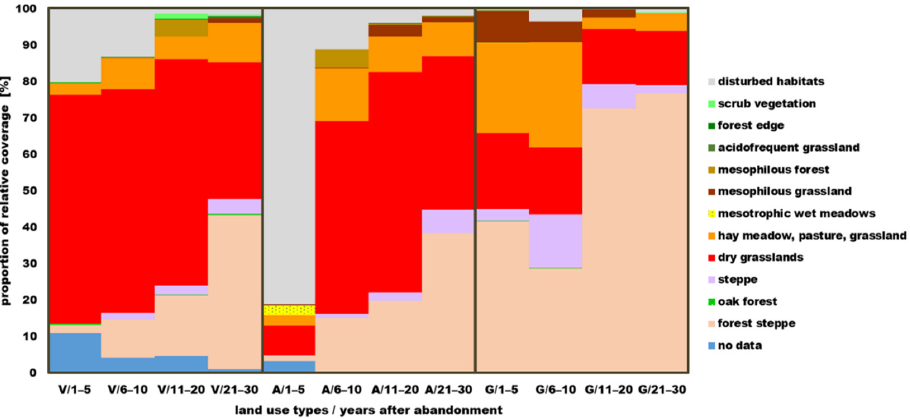
Figure 6. Distribution of the relative coverage of habitat category in different age groups of abandoned lands (V—vineyards, A—arable land, G—grasslands).